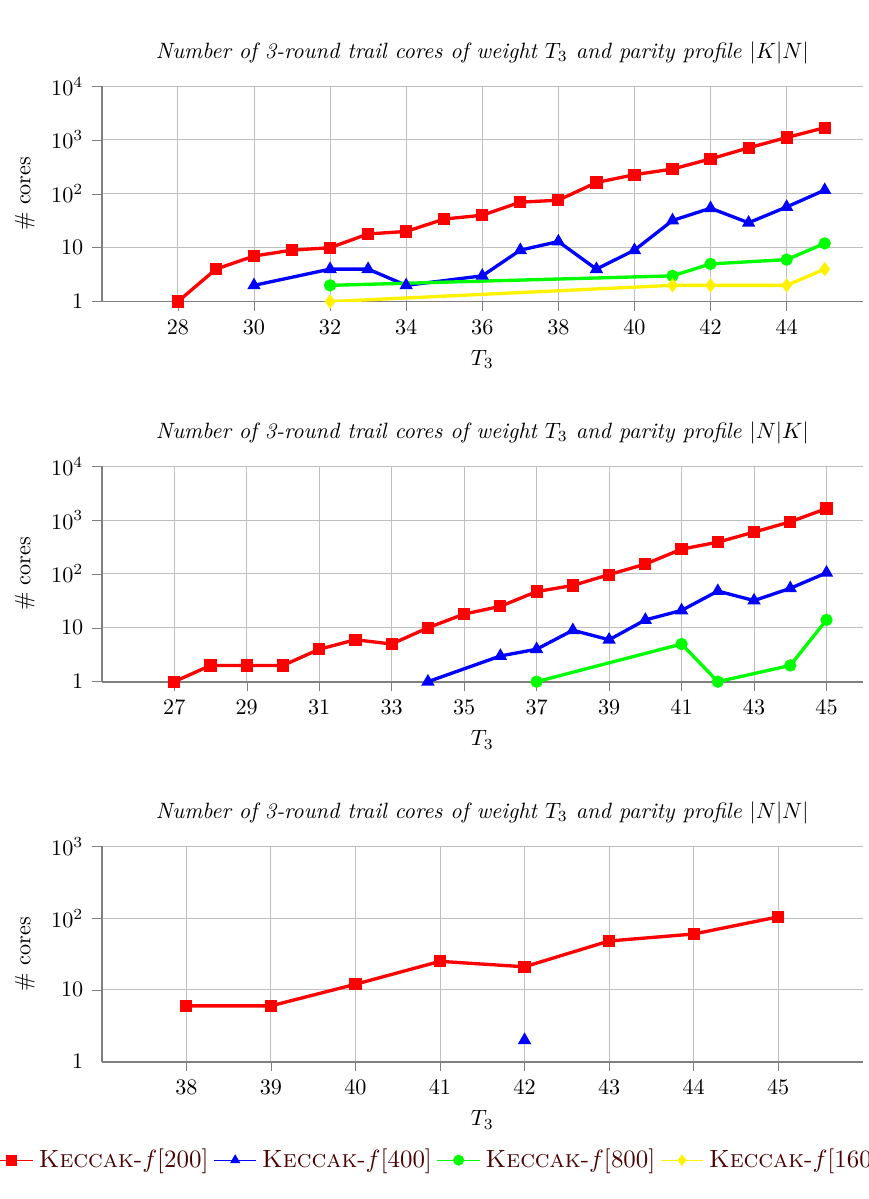
Figure 7: Number of 3-round trail cores with weight T 3 for different parity